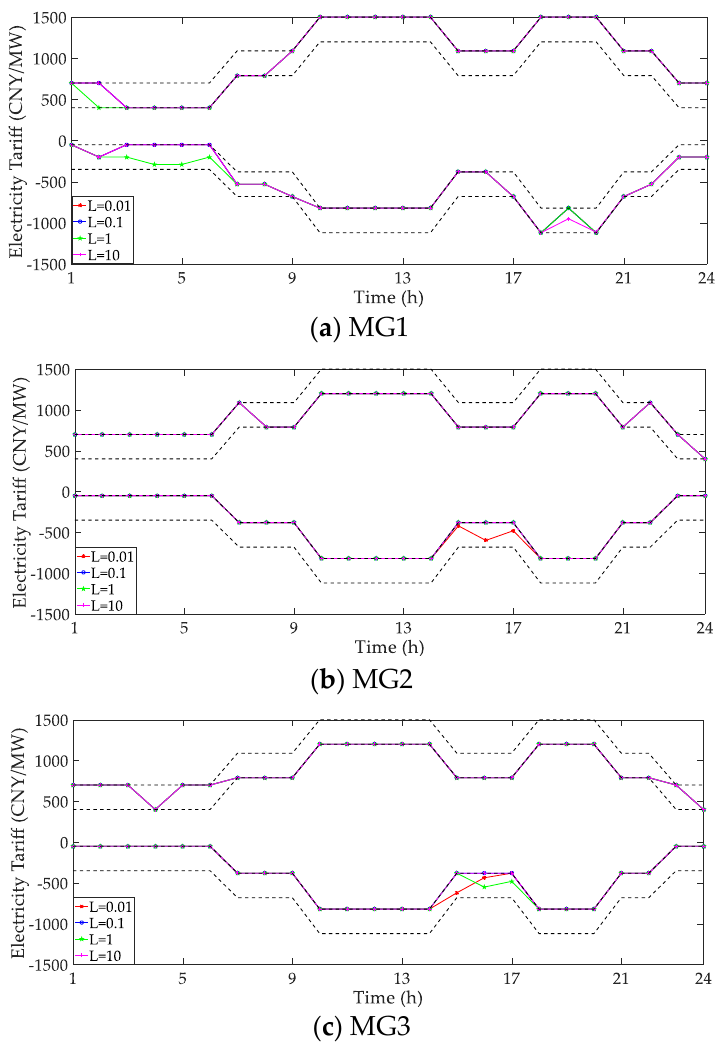
Figure 5. Electricity tariff between MA and MGs when P2P energy sharing is allowed.